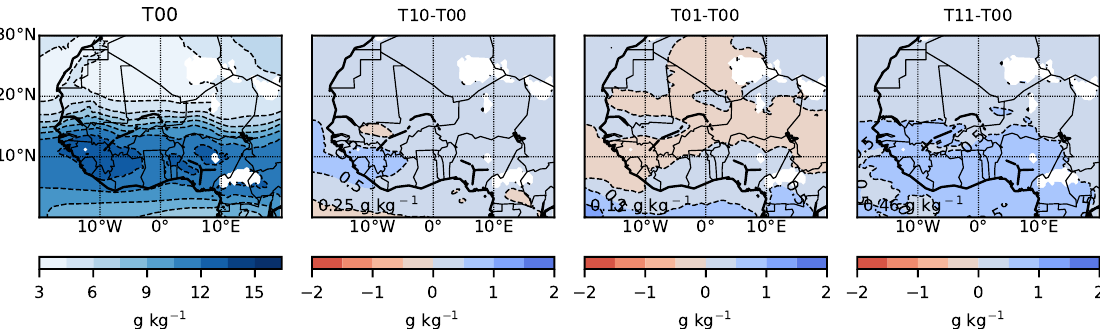
Figure 8. Mean JAS 925 hPa specific humidity for the control simulation and sensitivity experiment anomalies. Values in the bottom left corner are study domain